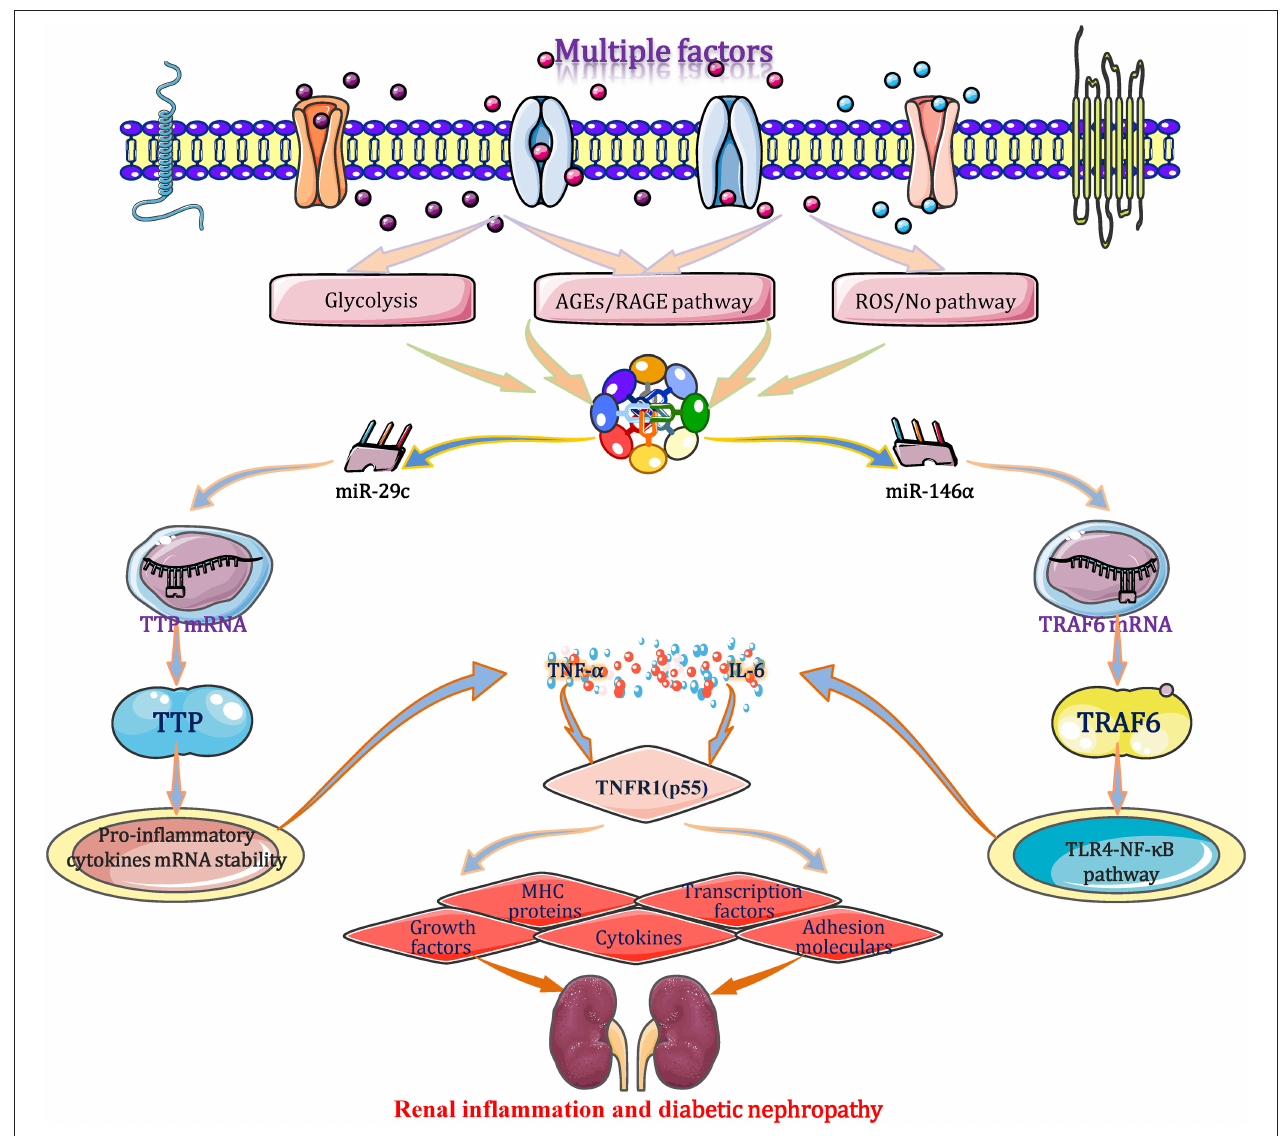
FIGURE 7 | miRNAs interfere with inflammation and immune in DN by affecting TNF- α expression. Under a diabetic state, the expression level of TNF- α is regulated by miRNAs (such as miR-29c, 146a, and miR-31) through several signaling pathways. TNF- α binds to the TNFR1 (p55) receptor, resulting in the production/expression of diverse effectors include adhesion molecules, major histocompatibility complex (MHC) proteins, cytokines, growth factors, transcription factors (TFs) and acute phase proteins, leading to direct renal cell cytotoxicity, apoptosis, intraglomerular haemodynamic alterations, and renal immune/inflammation responses. These alterations play important roles in the courses of inflammatory and immune in DN and may be exploited as potential therapeutic strategies for DN based on the miRNA targets. MHC, major histocompatibility complex; TLR4, toll-like receptor 4; TNFR1, tumor necrosis factor- α receptor 1; TTP, tristetraprolin; TRAF6, tumor necrosis factor receptor associated factor